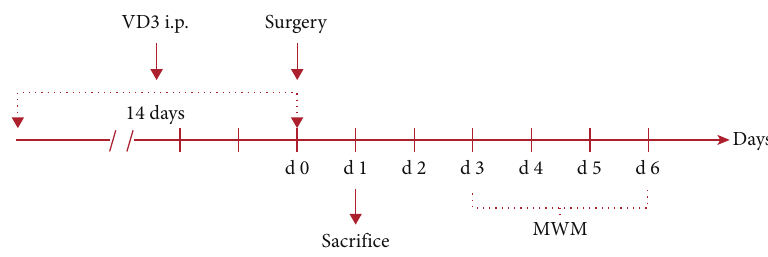
Figure 1: Experimental design. MWM: Morris water